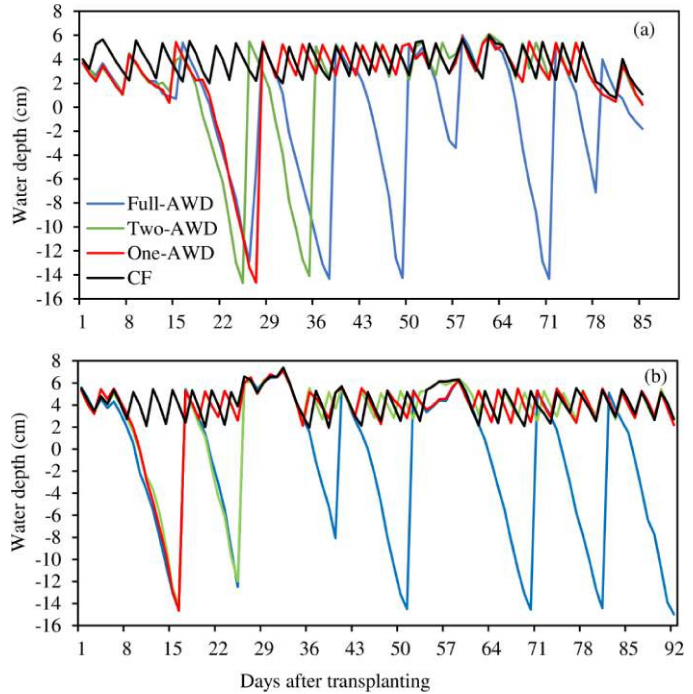
Figure 2. Seasonal variation in daily water depth during dry ( a ) and wet ( b ) rice growing seasons for different water management practices. Full-AWD—wetting and drying cycles throughout the growing season, Two-AWD—two early drying periods, One-AWD—one early drying period, CF—continuous